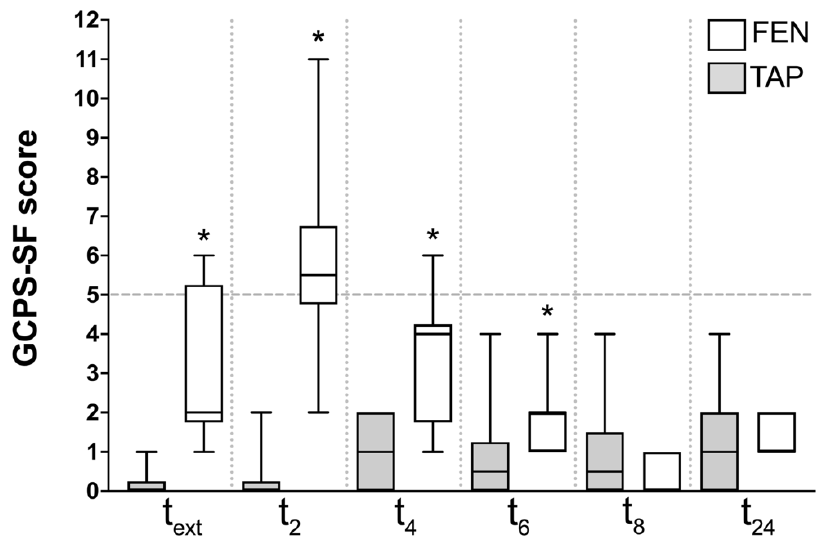
Figure 1. Box and whisker plots of pain scores’ distribution at different time points. The asterisk indicates statistically significant difference between the groups at that specific time point. The dotted line indicates the intervention threshold (score at which rescue analgesia was administered).